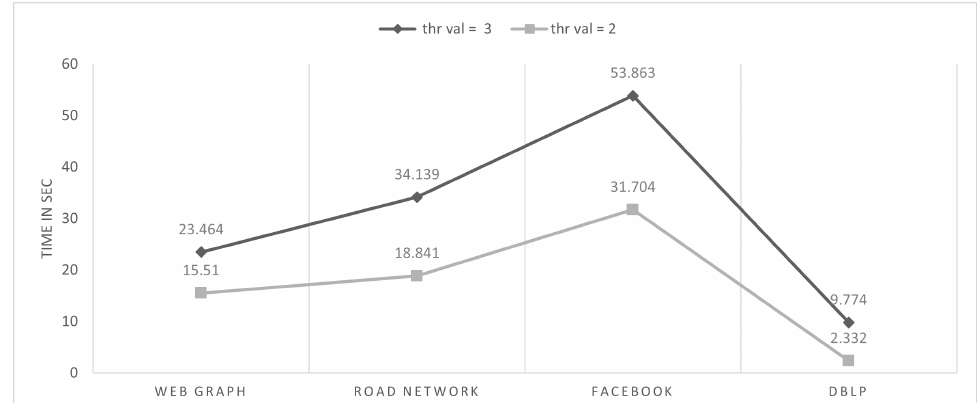
Figure 8. Processing time of each dataset choosing different threshold values.